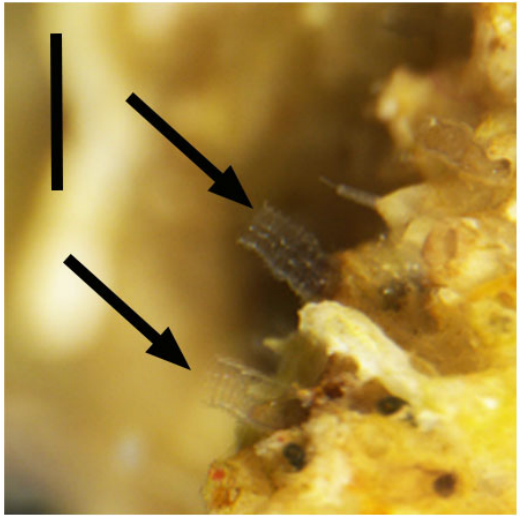
Figure 9. Experimental zooids and colony. Two new tubes are indicated by arrows. Scale bar 800 µm.